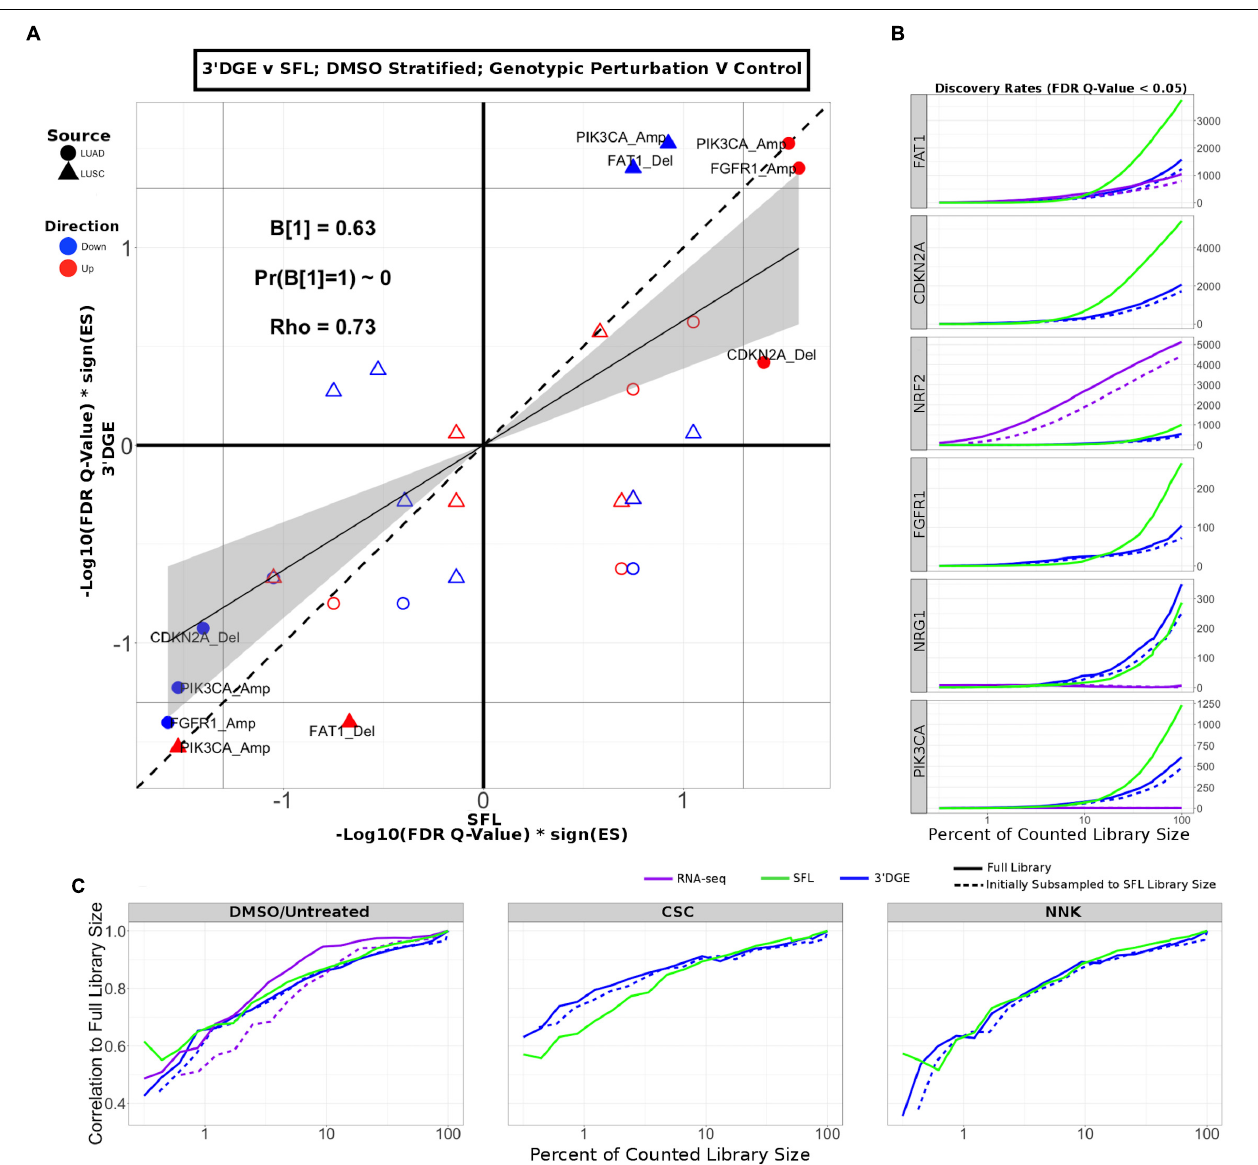
FIGURE 5 | Comparison of gene-set enrichment of gene mutation signatures across SFL and 3 (cid:48) DGE. (A) Comparison of the gene set enrichment results between SFL and 3 (cid:48) DGE with respect to the “DMSO-treated; genotypic perturbation vs. control” differential signatures. Points indicate gene set enrichment against concordant signatures, e.g., PIK3CA mutation and CNA gene sets against the “PIK3CA vs. HcRed” differential signatures. Shown are the transformed FDR Q -values from permutation-based testing by pre-ranked GSEA. | –Log10(FDR Q -Values)| corresponding to the FDR = 0.05 significance thresholds are shown as vertical and horizontal gray lines for the y - and x -axes, respectively. The names of the gene sets whose enrichment meets this threshold in either of the two platforms are shown and their points are filled in. Colors and shape of points denote direction and source of the gene set, respectively. Additional results for CSC, NNK, and BaP stratified genotypic perturbation signatures, as well as comparisons between full coverage RNA-seq and either SFL and 3 (cid:48) DGE are shown in Supplementary Figure S9 . (B) Discovery rates for genotypic perturbations across full coverage poly-A RNA-seq, SFL, and 3 (cid:48) DGE, for chemically untreated (full coverage RNA-seq) and DMSO treated (SFL and 3 (cid:48) DGE) samples. Results demonstrate full counted library size, as well as subsampled libraries. (C) Correlation between transformed FDR Q -values from gene set enrichment at different subsamples of each platform and the results from the full counted library size. Shown are the results from genotypic perturbations from untreated (full coverage RNA-seq)/DMSO treated (SFL and 3 (cid:48) DGE), CSC, and NNK chemically treated samples.